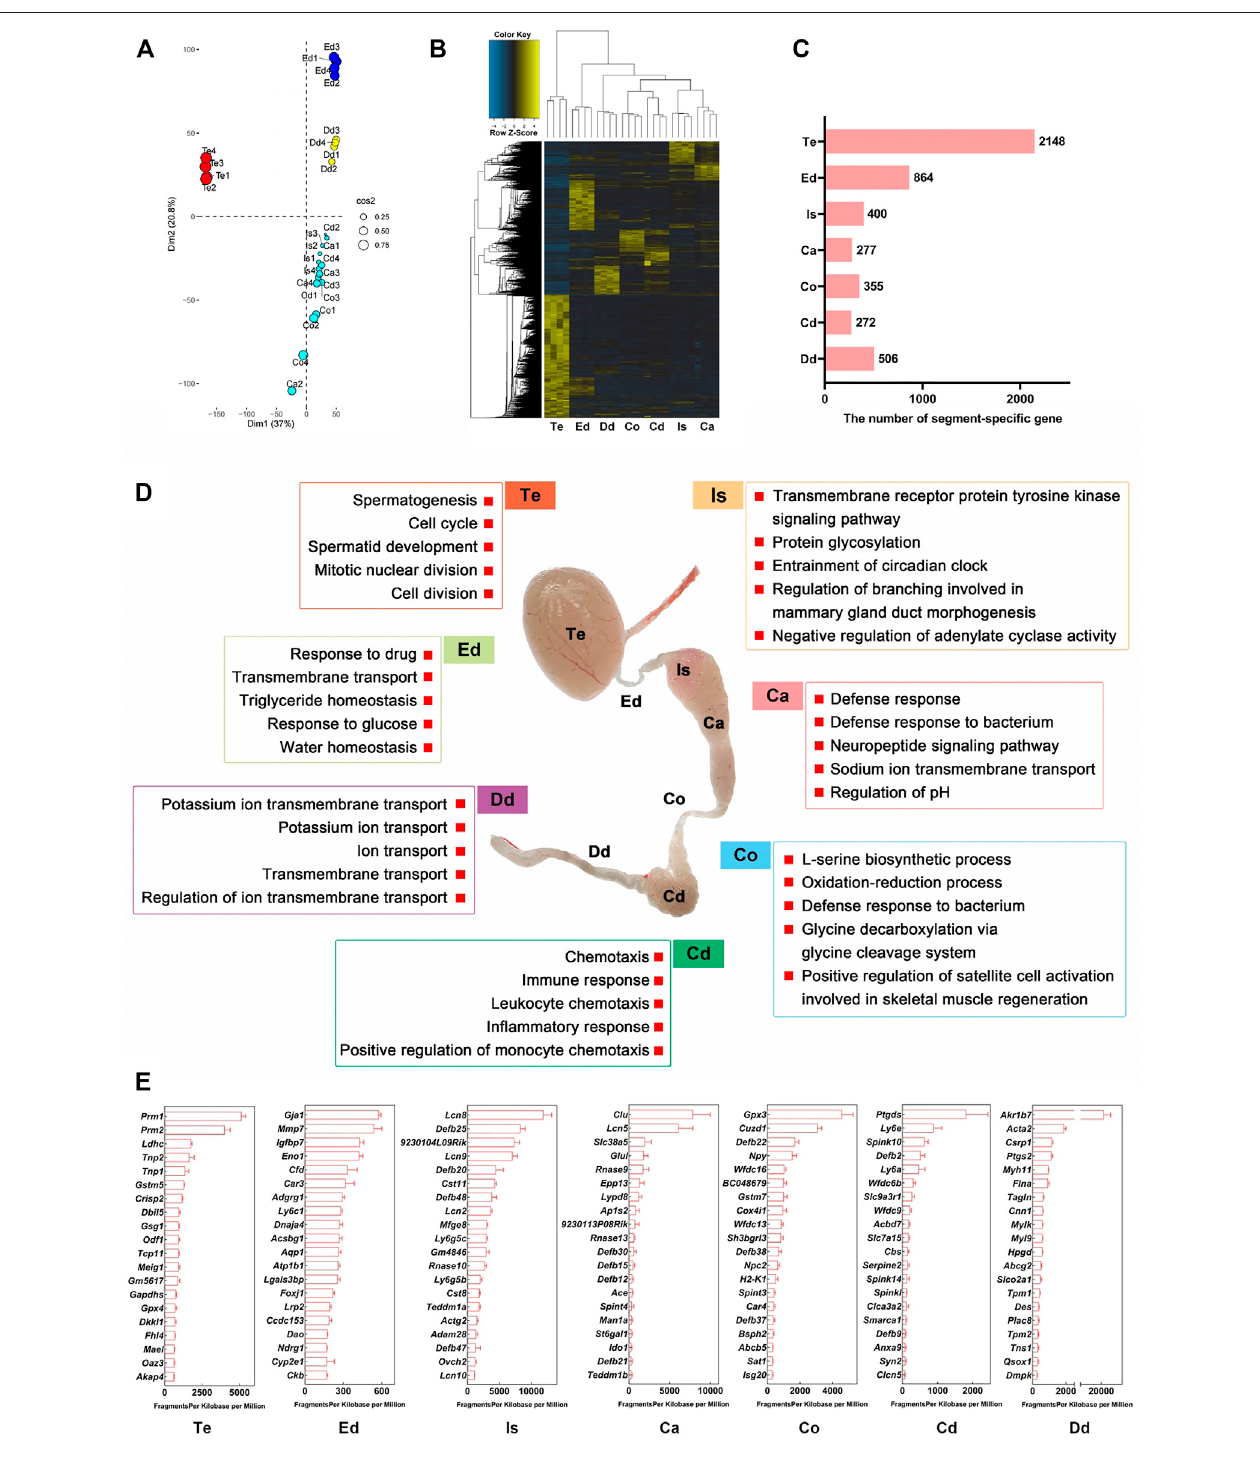
FIGURE2 | Transcriptome landscape ofthe male reproductive tract in adult mice. (A) Principal componentanalysis (PCA) ofRNA-seq data for seven regions from 3-month-old mice ( n (cid:2) 4). (B) Heatmap of region-speci fi c genes. Genes with fold change ≥ 4 relative to levels in the other 6 regions and p < 0.05 are de fi ned as region- speci fi c genes. (C) Number of region-speci fi c genes. (D) Gene Ontology enrichment analysis of region-speci fi c genes. (E ) Top 20 region-speci fi c genes. Te: testis; Ed: efferent ductules; Is: initial segment; Ca: caput; Co: corpus; Cd: cauda; Dd: ductus deferens.